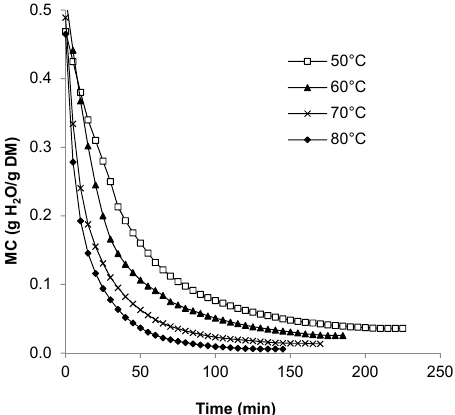
Figure 2. Drying curves for pumpkin seeds dried at different temperatures at a fixed air velocity of 2.87 m/s.